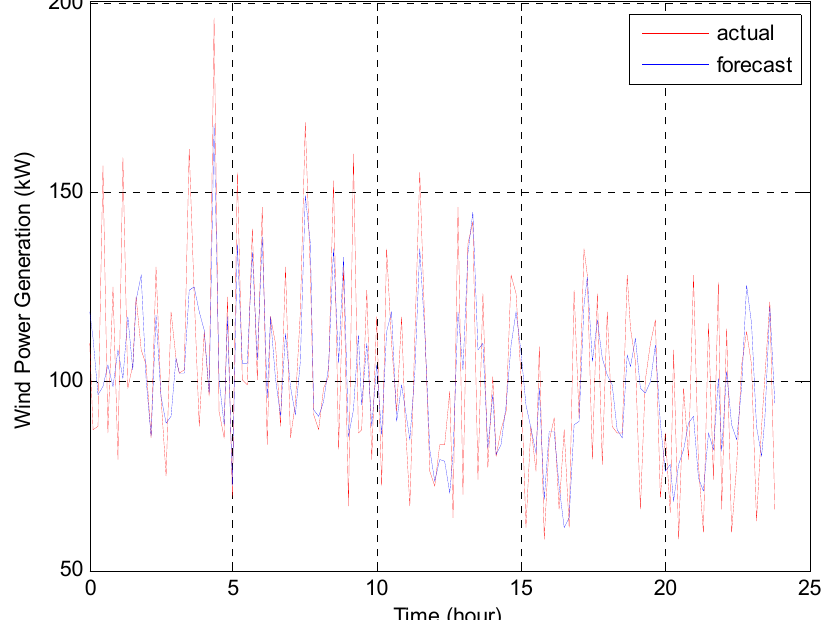
Figure 9. Test results with the RBF neural network based method for typical summer